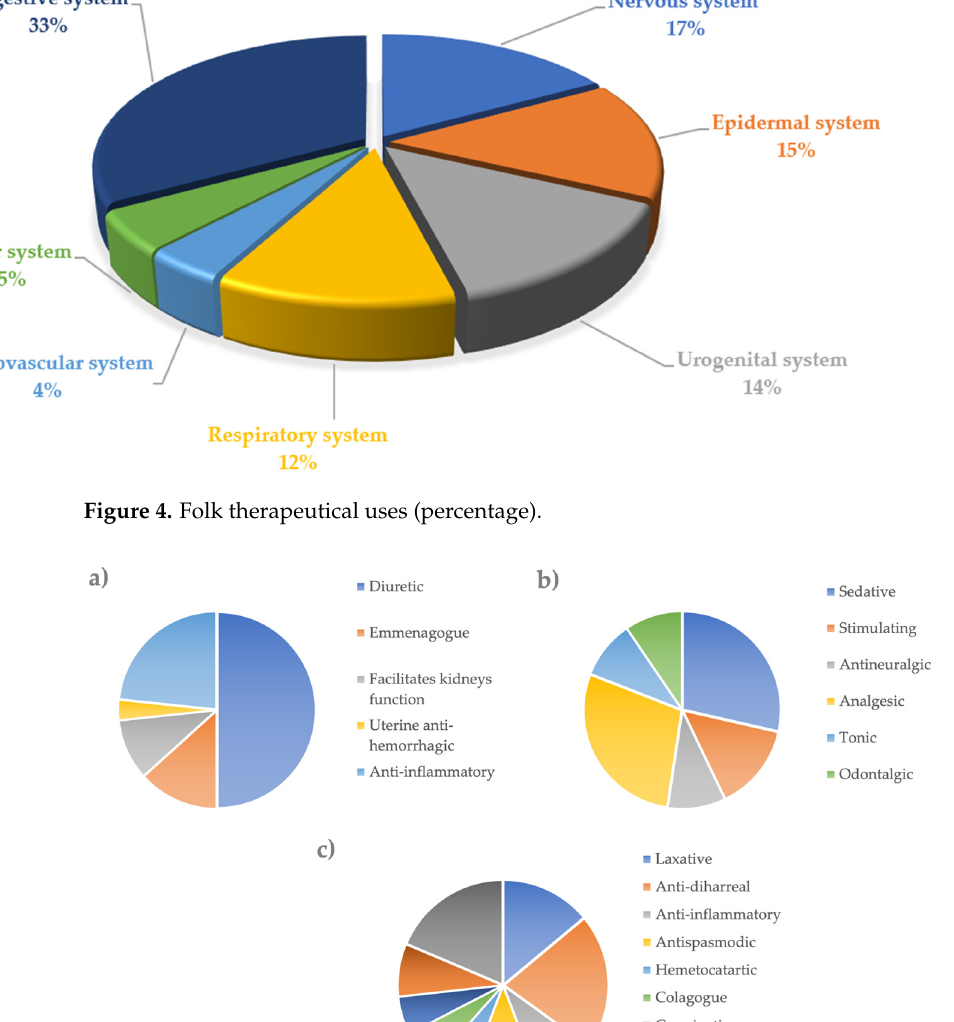
16 of 27 Figure 3. Preparations of the herbal drugs (percentage).